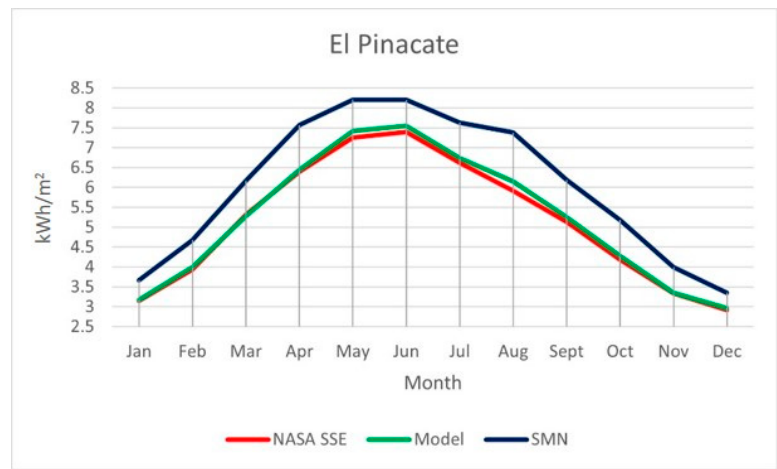
Figure 3. Comparison between the SMN, NASA SSE, and the model for the station of El Pinacate.